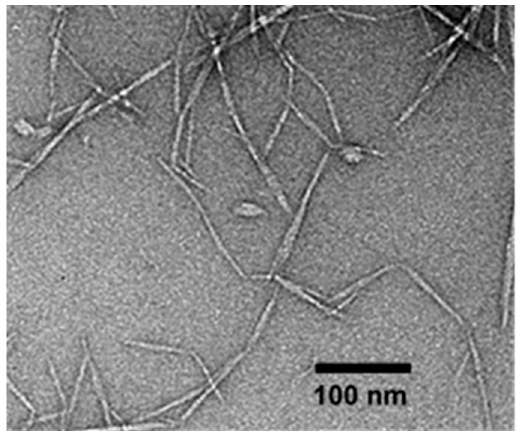
Figure 1. Transmission electron microscopy (TEM) image of never-dried oxidised cellulose nanofibrils (OCNF).